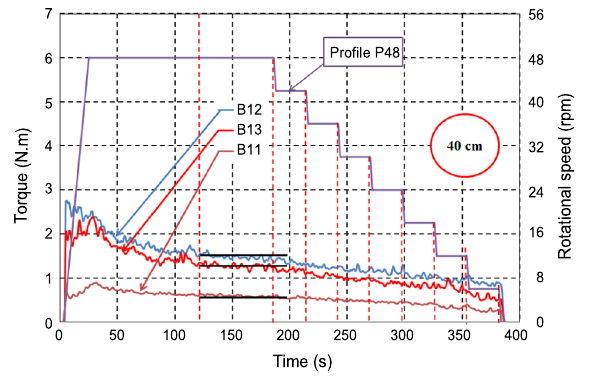
Fig. 9. Results of the container with a diameter of 40 cm